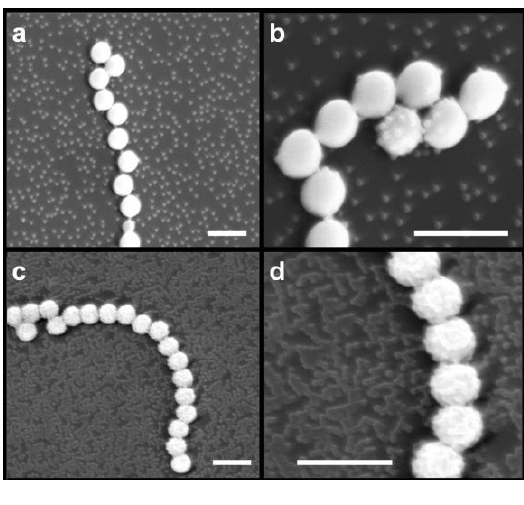
Figure 4. Colloidal strings formed by electric-field induced ordering of latex particles that are glued together through heteroaggregation with microgel particles. The scale bars represent 2 μm (reproduced with permission from reference [28]).